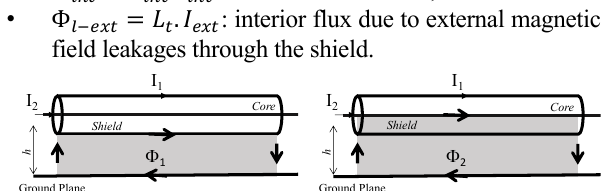
Ground FIGURE 5. Physical significance of F 1 and F 2 in the single-reference model of the coaxial problem